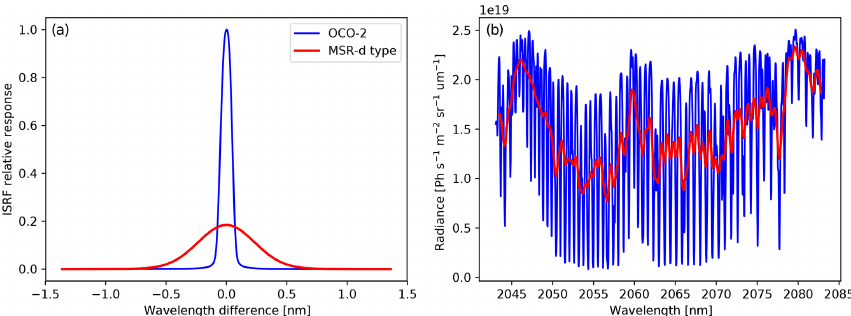
Figure 1. Example spectra and instrument spectral response functions of the OCO-2 and MSR-d instruments in the 2 . 06µm band. Both OCO-2 and MSR-d ISRFs are scaled to the maximum of OCO-2 ISRF. Table 3. XCO 2 retrieval performance for synthetic OCO-2 and MSR-d measurements. Intensity offsets are added to spectra in test 2 and test 3 but only fitted for test 3. The bias and the single-sounding accuracy are the mean and standard deviation of differences between retrievals and truths, respectively. Noise errors are retrieval uncertainties from linear noise propagation. Bias (ppm) Single-sounding accuracy (ppm) Mean retrieval noise (ppm) Convergence percentage OCO-2 syn MSR-d syn OCO-2 syn MSR-d